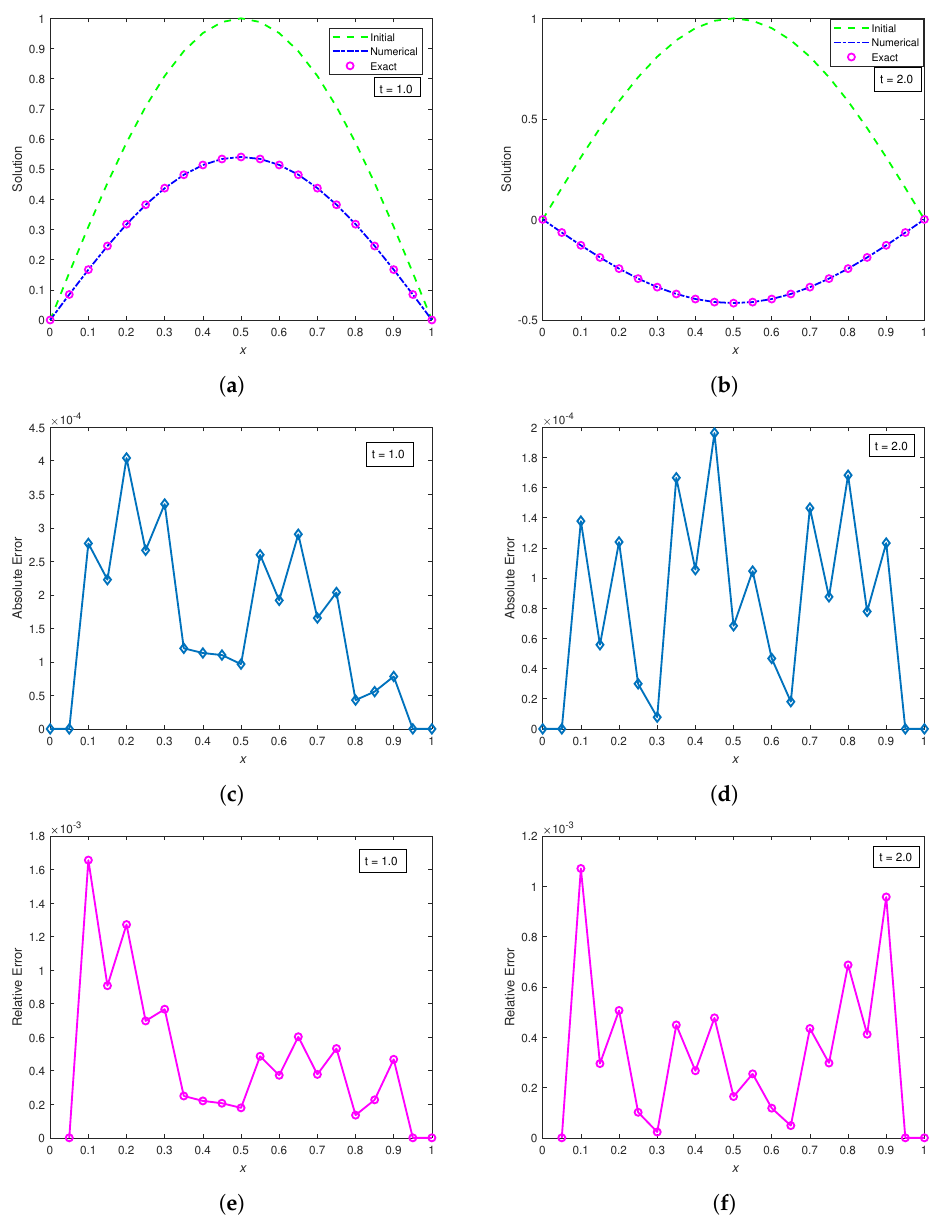
Figure 10. Plots of the exact and numerical solution vs. x ∈ [ 0,1 ] at times t = 1.0, 2.0, using a classical finite difference scheme with ∆ t = 10 − 5 , ∆ x = 0.05, with corresponding absolute and relative errors vs. x (at times 1.0, 2.0), respectively. ( a ) ∆ t = 1.0 × 10 − 5 , (Time = 1.0); ( b ) ∆ t = 1.0 × 10 − 5 , (Time = 2.0); ( c ) ∆ t = 1.0 × 10 − 5 , (Time = 1.0); ( d ) ∆ t = 1.0 × 10 − 5 , (Time = 2.0); ( e ) ∆ t = 1.0 × 10 − 5 ,